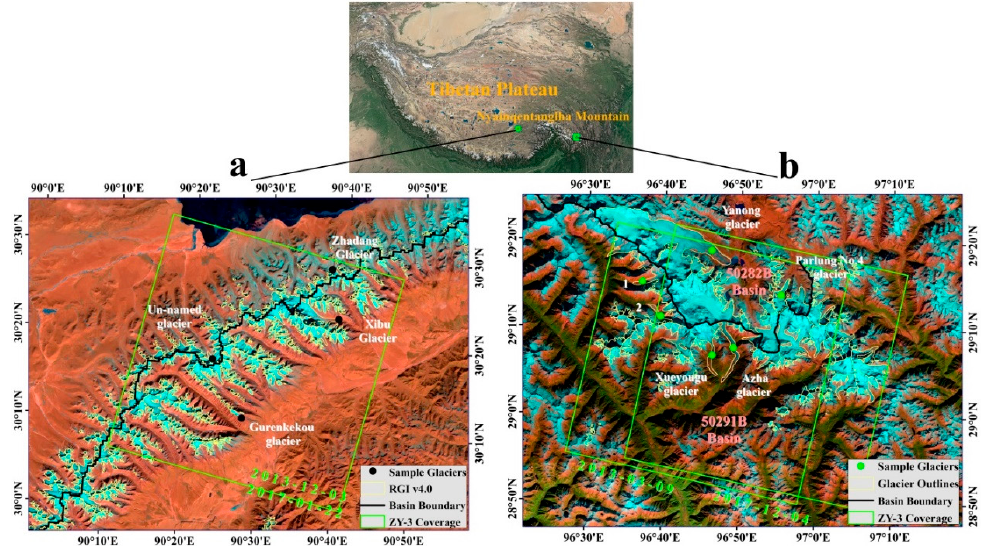
Figure 1. Overview of the study areas, ( a ): Western Nyainqentanglha Mountains (WNM); ( b ): Eastern Nyainqentanglha Mountains (ENM). The green rectangles and characters represent the coverage and acquisition time of ZiYuan-3 Three-Line-Array (ZY-3 TLA) data, the yellow polygons represent the glacier outlines, the black and green points represent sample glaciers and the thick black lines are the boundaries of the basins. (Background: Sentinel 2A false color images of band 11 (SWIR), band 8 (NIR), band 4 (R) shown in red, green, blue composition).